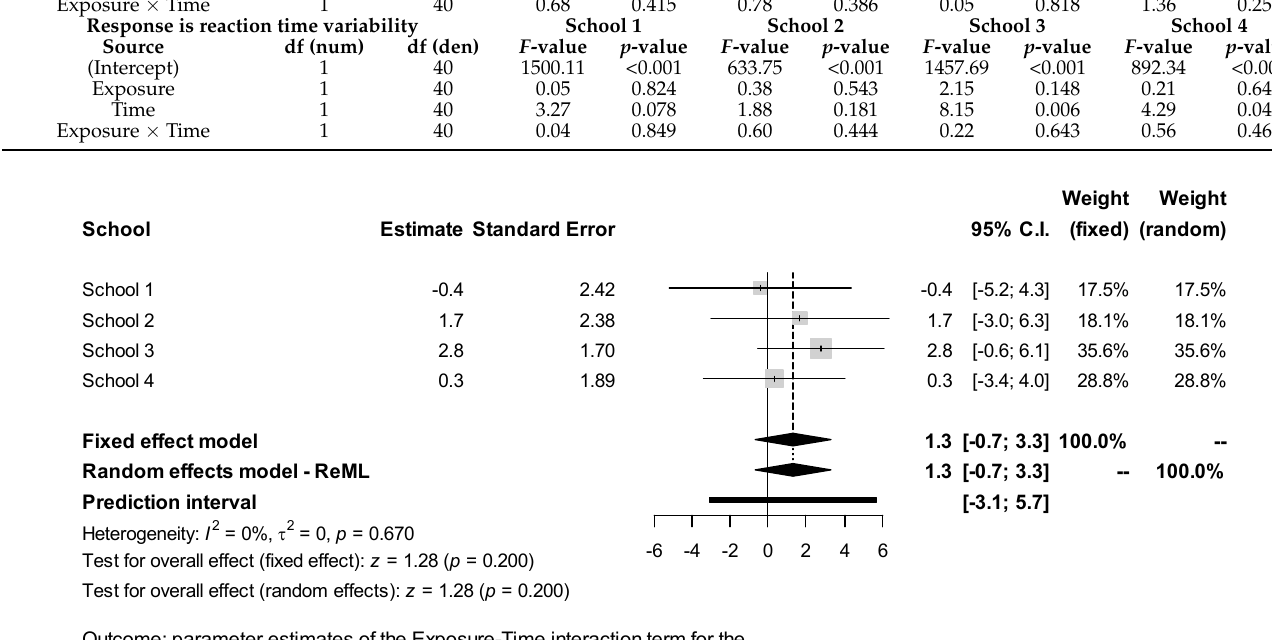
Figure 2. Meta-analysis for test response test Figure 2. Meta ‐ analysis for test response test score.